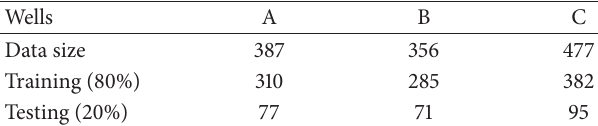
Table 1: Number of available data points.